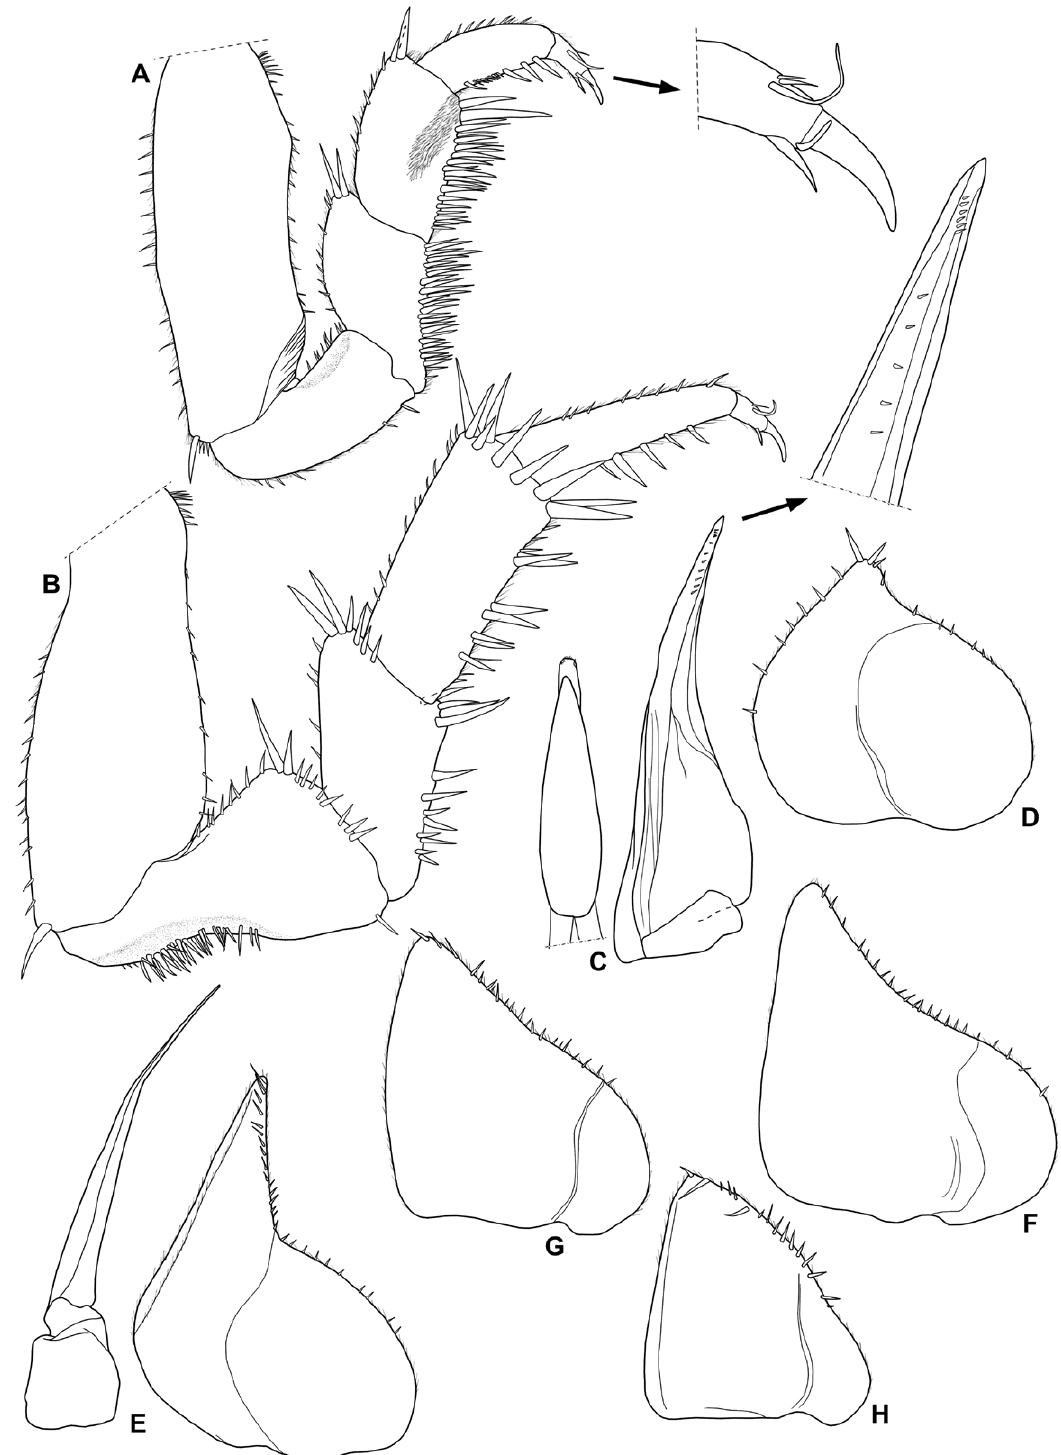
Figure 3. Alloniscus buckupi Campos-Filho & Cardoso n. sp., holotype. A, pereopod 1; B, pereopod 7; C, genital papila and pleopod 1 endopod; D, pleopod 1 exopod; E, pleopod 2; F, pleopod 3 exopod; G, pleopod 4 exopod; H, pleopod 5